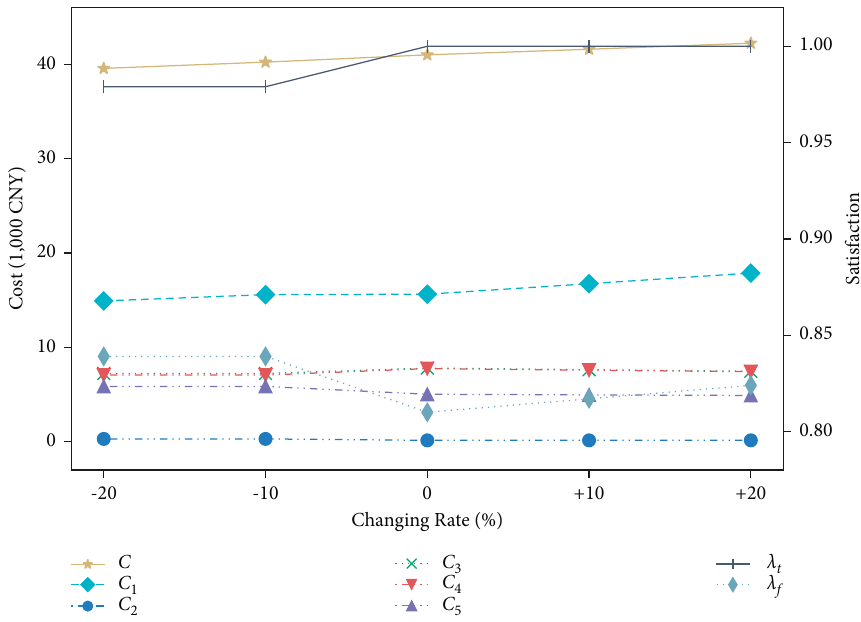
Figure 9: Cost and satisfaction of optimal paths with different railway transport